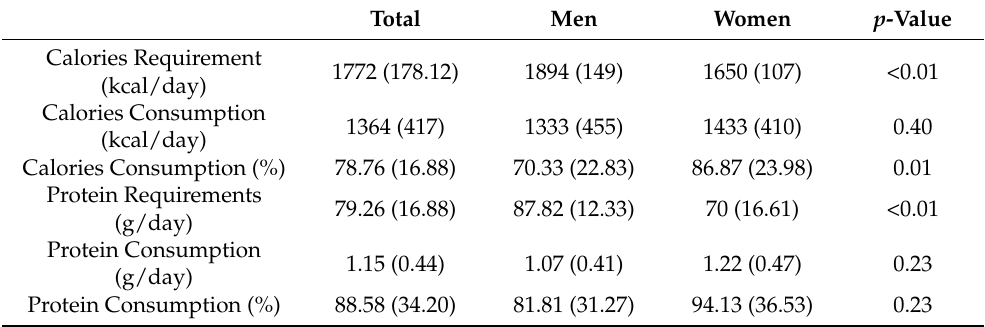
Table 3. Difference in calorie and protein requirements and consumption between men and women.